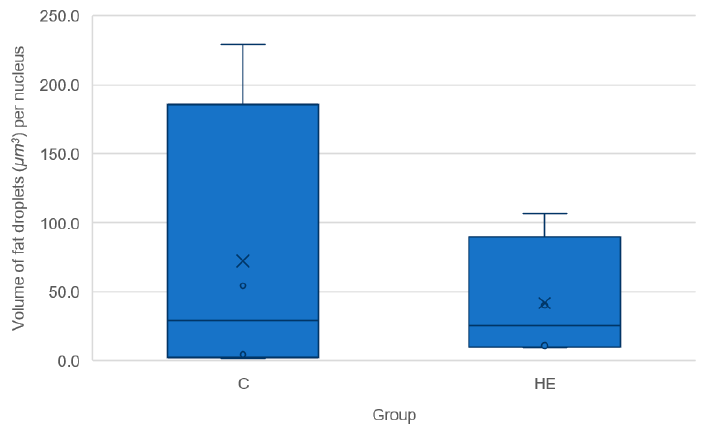
Figure 10. The total volume of fat droplets (µm 3 ) divided by the total number of cells for blastocysts recovered form Shetland pony mares fed either a control (maintenance; n = 4) or high-energy diet (HE; 200% net energy requirements; n = 4).